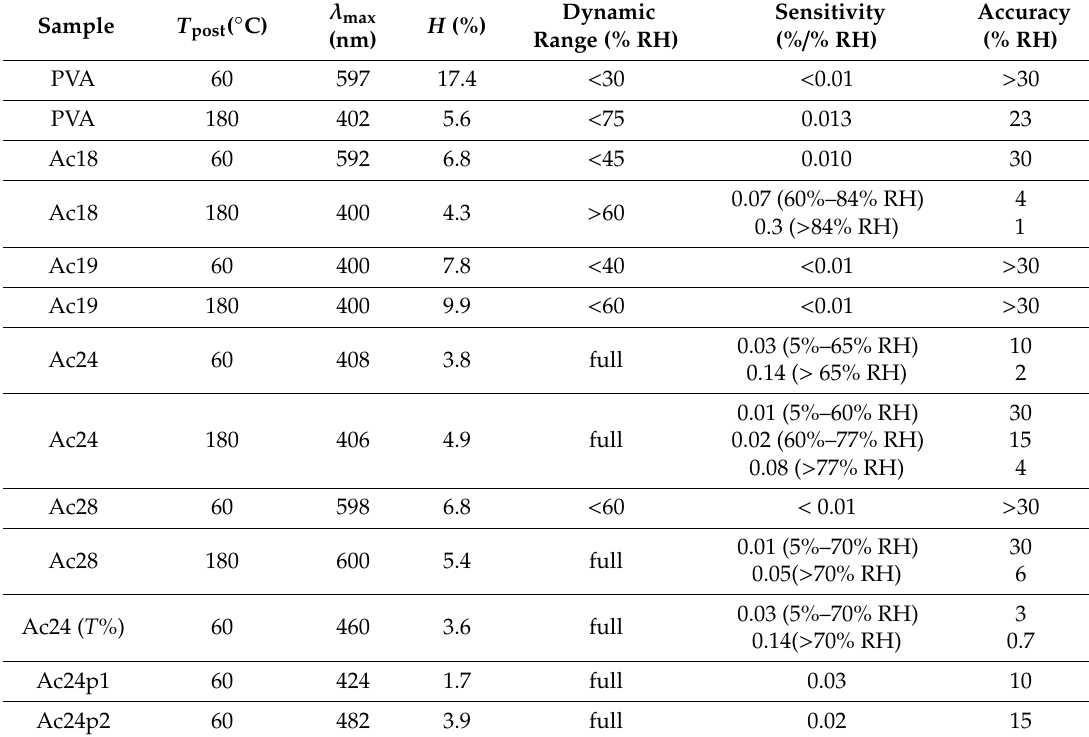
Table 2. Post-annealing temperature ( T post ), wavelength at which R ( T ) measurements were conducted ( λ max ), percentage of hysteresis ( H ), dynamic range, sensitivity, and accuracy for studied